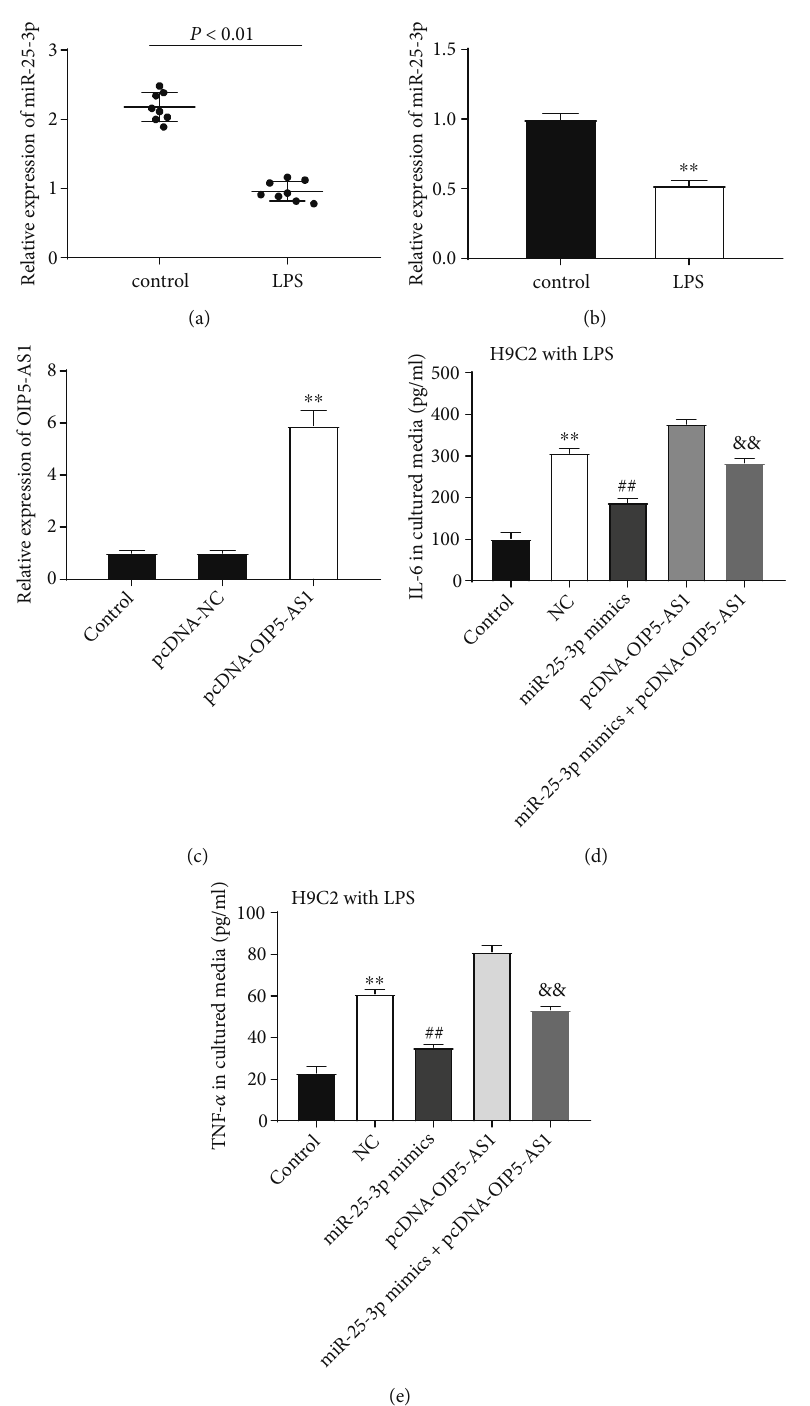
Figure 6: The regulatory role of OIP5-AS1 on LPS-induced in fl ammation is associated with miR-25-3p. (a) Relative expression of miR-25- 3p in myocardial tissues from LPS-induced rats was determined by qRT-PCR. (b) Relative expression of miR-25-3p in LPS-treated H9C2 cells was determined by qRT-PCR. ** P < 0 : 01 versus control. (c) The e ffi ciency of OIP5-AS1 overexpression in H9C2 cells was detected by qRT-PCR. ** P < 0 : 01 versu s pcDNA-NC. (d and e) The levels of IL-6 and TNF- α in culture supernatants of H9C2 cells were measured by ELISA. ** P < 0 : 01 versus control. ## P < 0 : 01 versus NC. && P < 0 : 01 versus